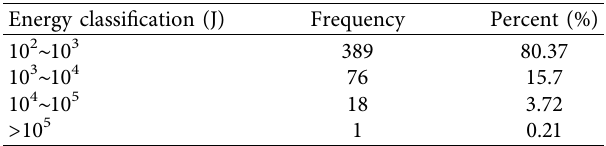
Table 1: Mine earthquake energy statistics in the 1305 working